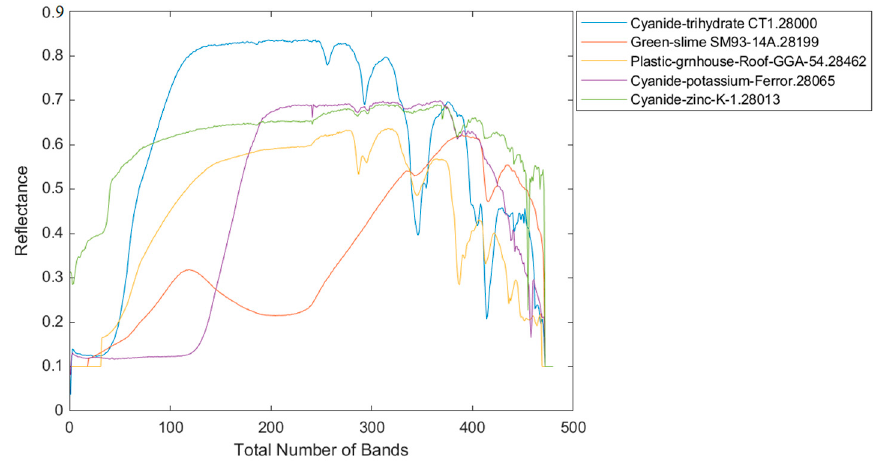
Figure 3 . Five selected endmembers from the USGS library. Figure 3. Five selected endmembers from the USGS library.